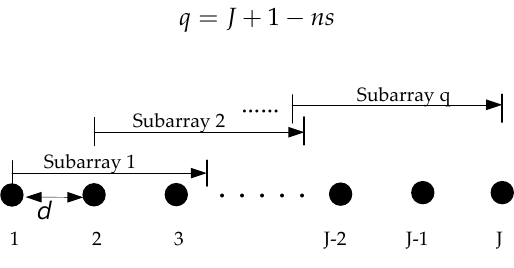
Figure 4. Spatial smoothing algorithm diagram.